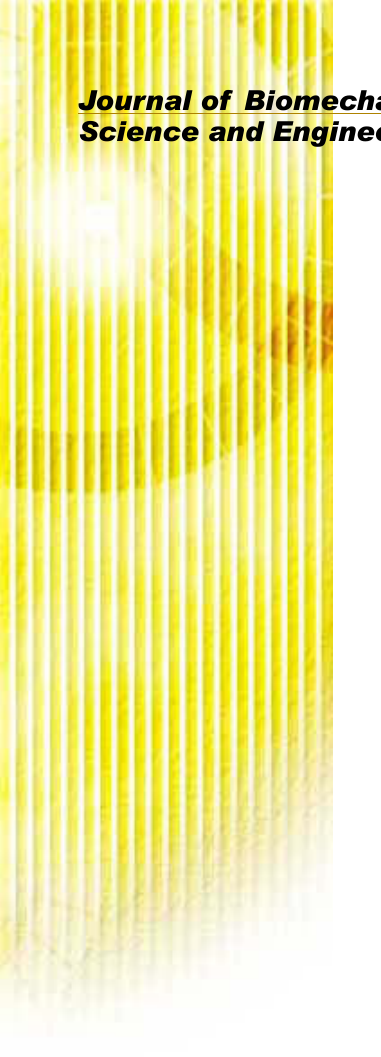
F . (c) Horizontal components, y